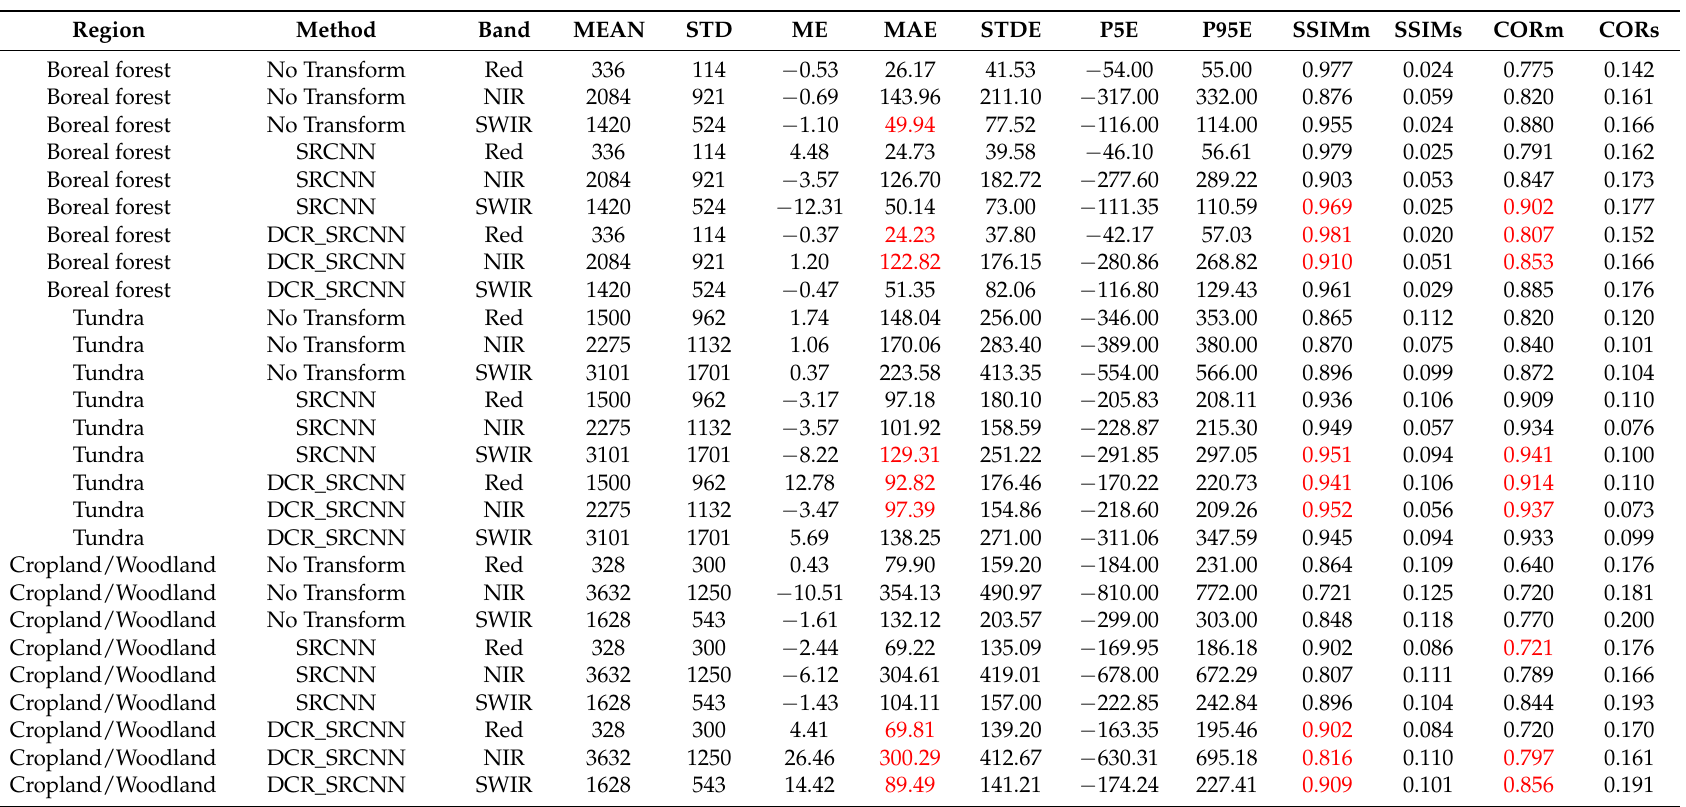
Table 3. Spatial extension performance